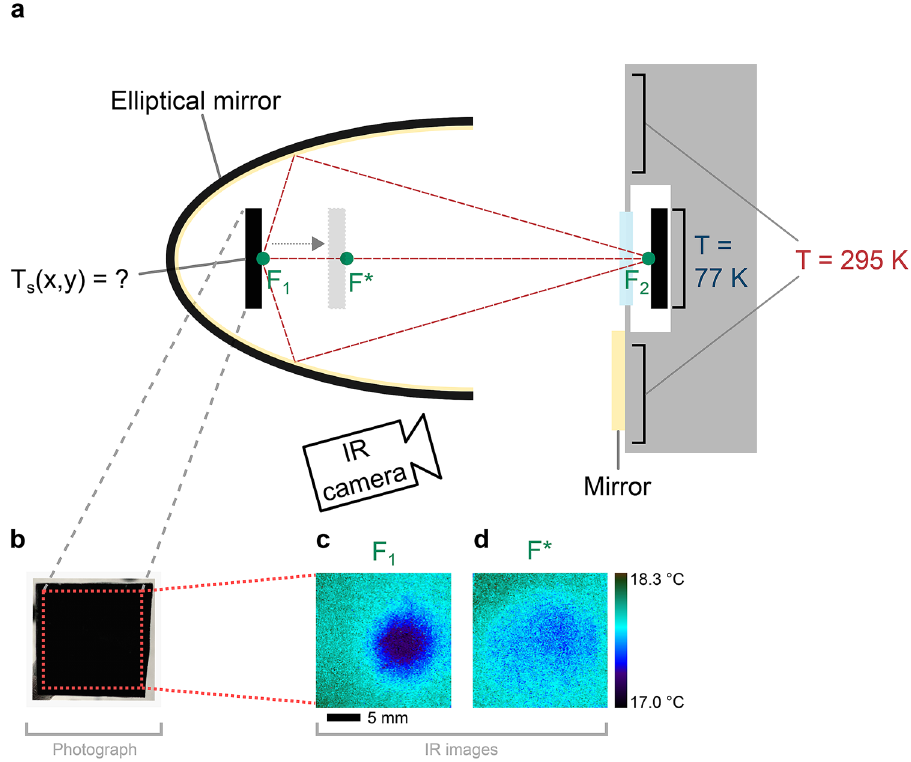
Figure 2. Schematic of the setup and resulting cooling pattern. ( a ) An elliptical mirror collects the thermal radiation emitted by a room temperature sample positioned at the focus point F 1 . The radiation is focused onto a sample at the second focal point F 2 , which is placed inside the cold region of a cryostat. A germanium window transparent for IR radiation (9–11 µm) seals the cryostat (SI, Figure S1). An additional mirror allows simultaneous temperature measurements with an IR camera. ( b ) Photograph of the “metal velvet” sample. ( c ) IR camera image of the sample at position F 1 . ( d ) IR camera image of the sample at position F*. The localized cold area vanishes when the substrate is placed out of